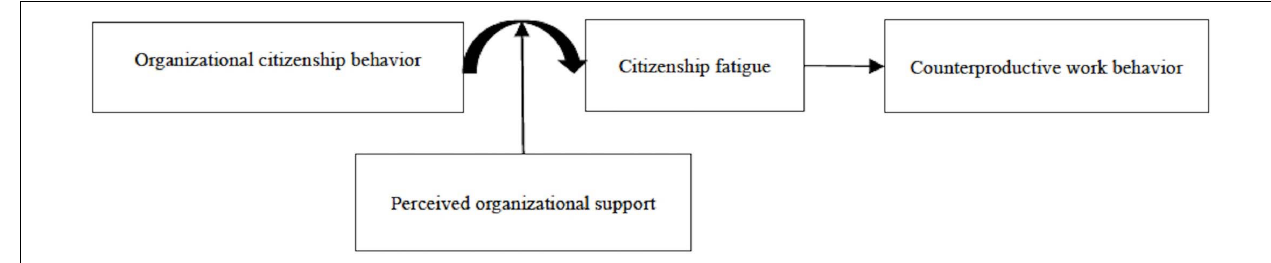
FIGURE 1 | The proposed research